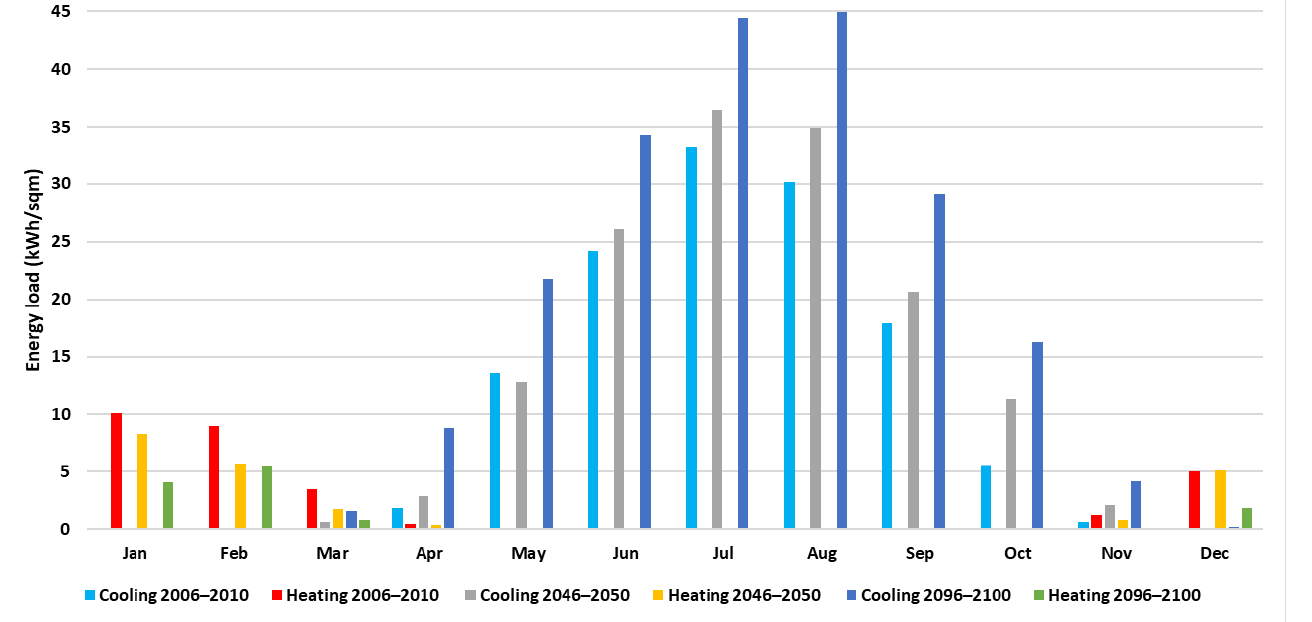
Figure 8. Monthly energy demand for HVAC purposes (comparative).